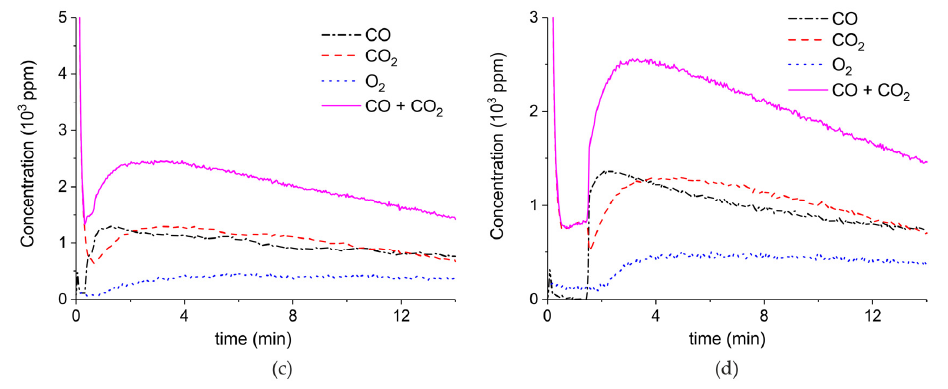
Figure A3. Concentration of the products of CaCO 3 decomposition (sample C) as function of time at 630 °C in pure argon and flow rate of 30 mL/min. Plasma power is 0.4, 3.2, and 9.6 W ( a ); 4.4 W ( b ); and 2.1 W ( c,d ). Plasma is turned on after 2 min and changed every 2 min (a) or at the beginning of the decomposition (b,c) or after 1.5 min (d).